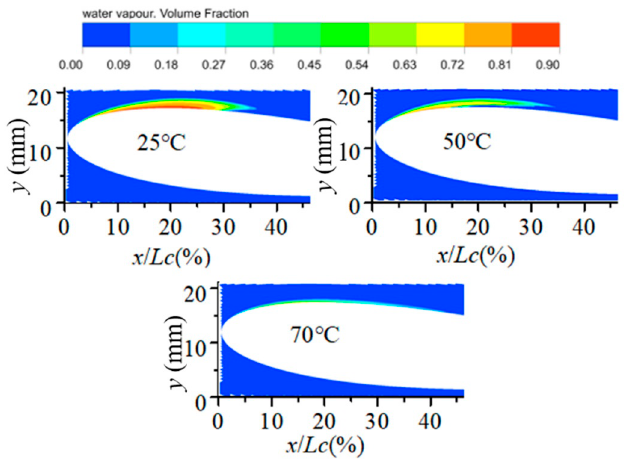
Figure 13. Vapor volume fraction distribution on the surface of the NACA0015 hydrofoil.